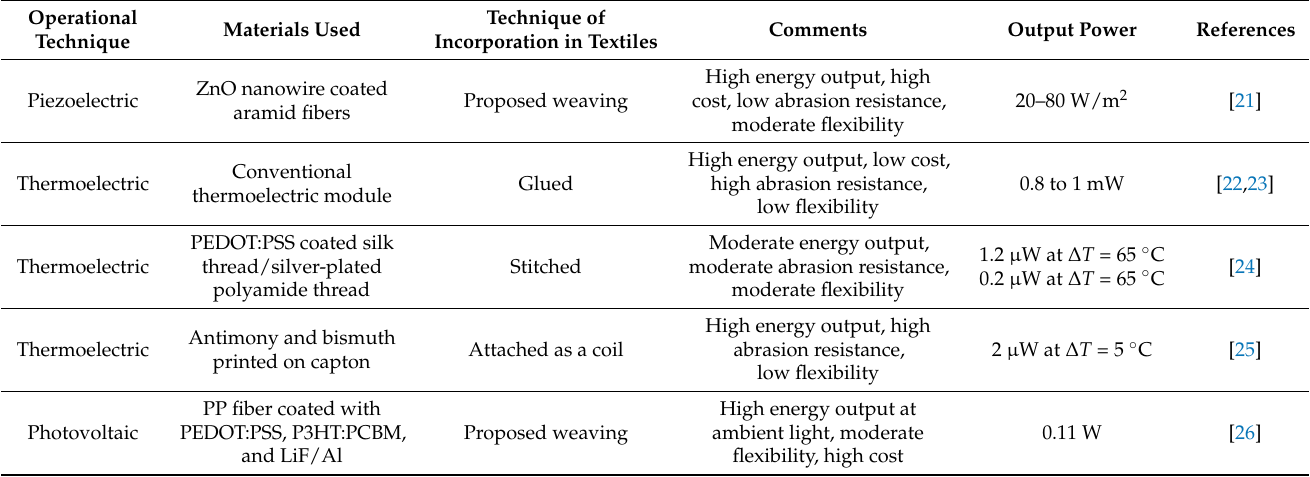
Table 3. Overview of different energy harvesting devices, designed to be integrated into